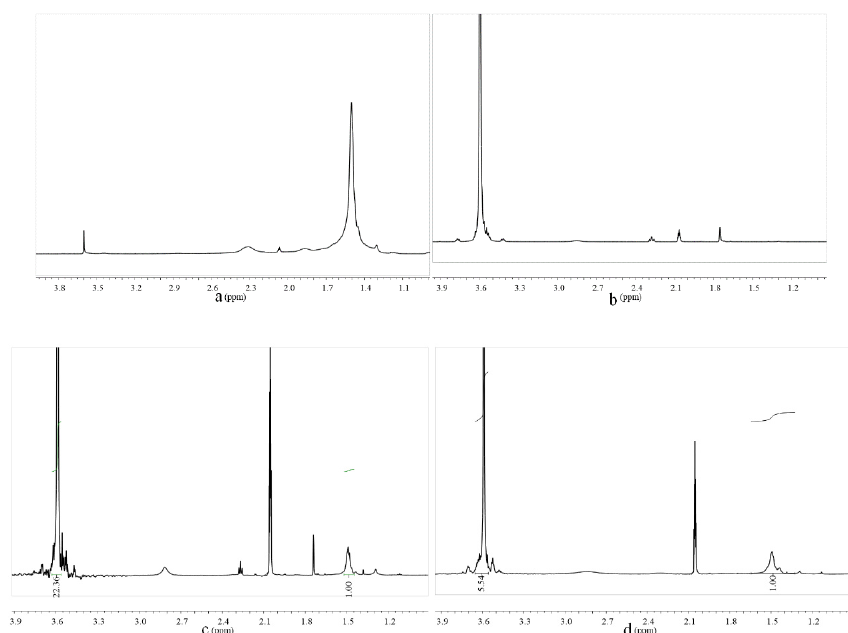
Figure 2. 1 HNMR spectrum of PtBA ( a ), TPEG ( b ), PtBA-PTPEG, ( c ) and PtBA-PTPEG-PtBA ( d ), respectively.